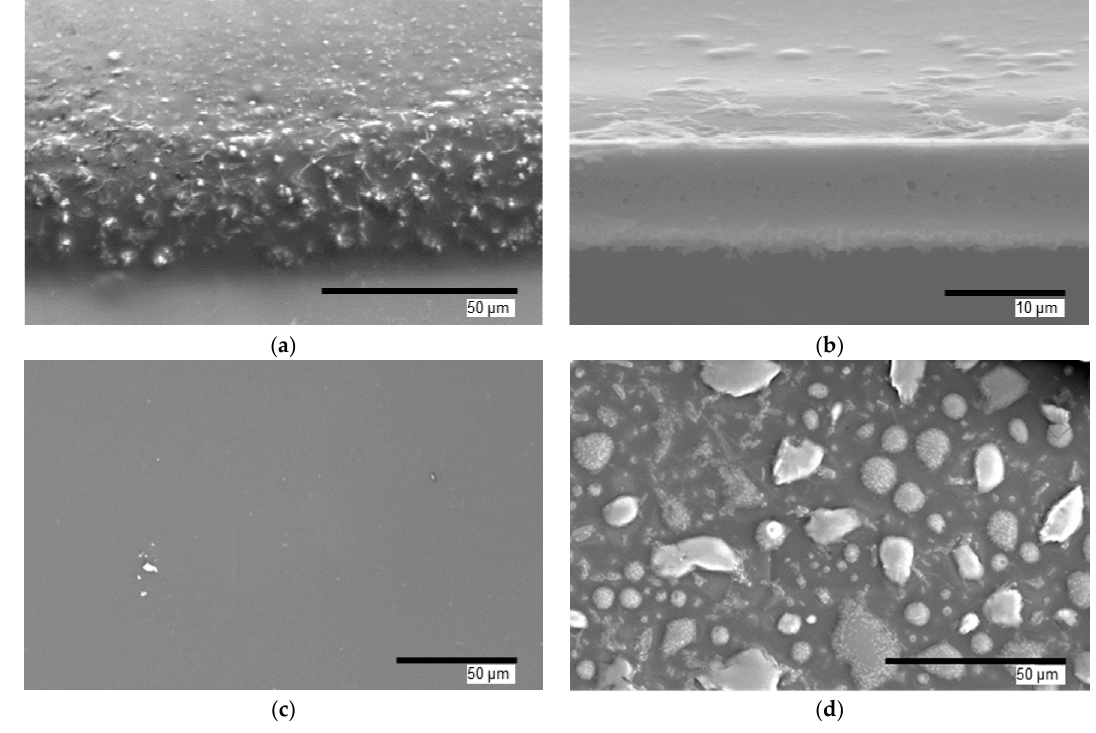
Figure 2. SEM of resulting drop-cast crosslinked gelatin films. Edge views of film ( a ) without exposure to enzyme solutions and ( b ) after exposure to trypsin, and top views of film ( c ) after exposure to trypsin and ( d ) after exposure to all three enzymes in buffer.